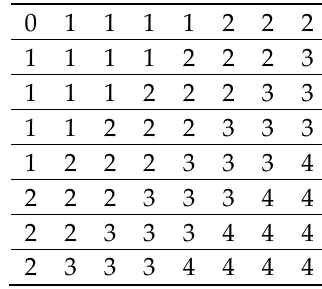
Figure 4. Four Spectral areas in the DCT domain.